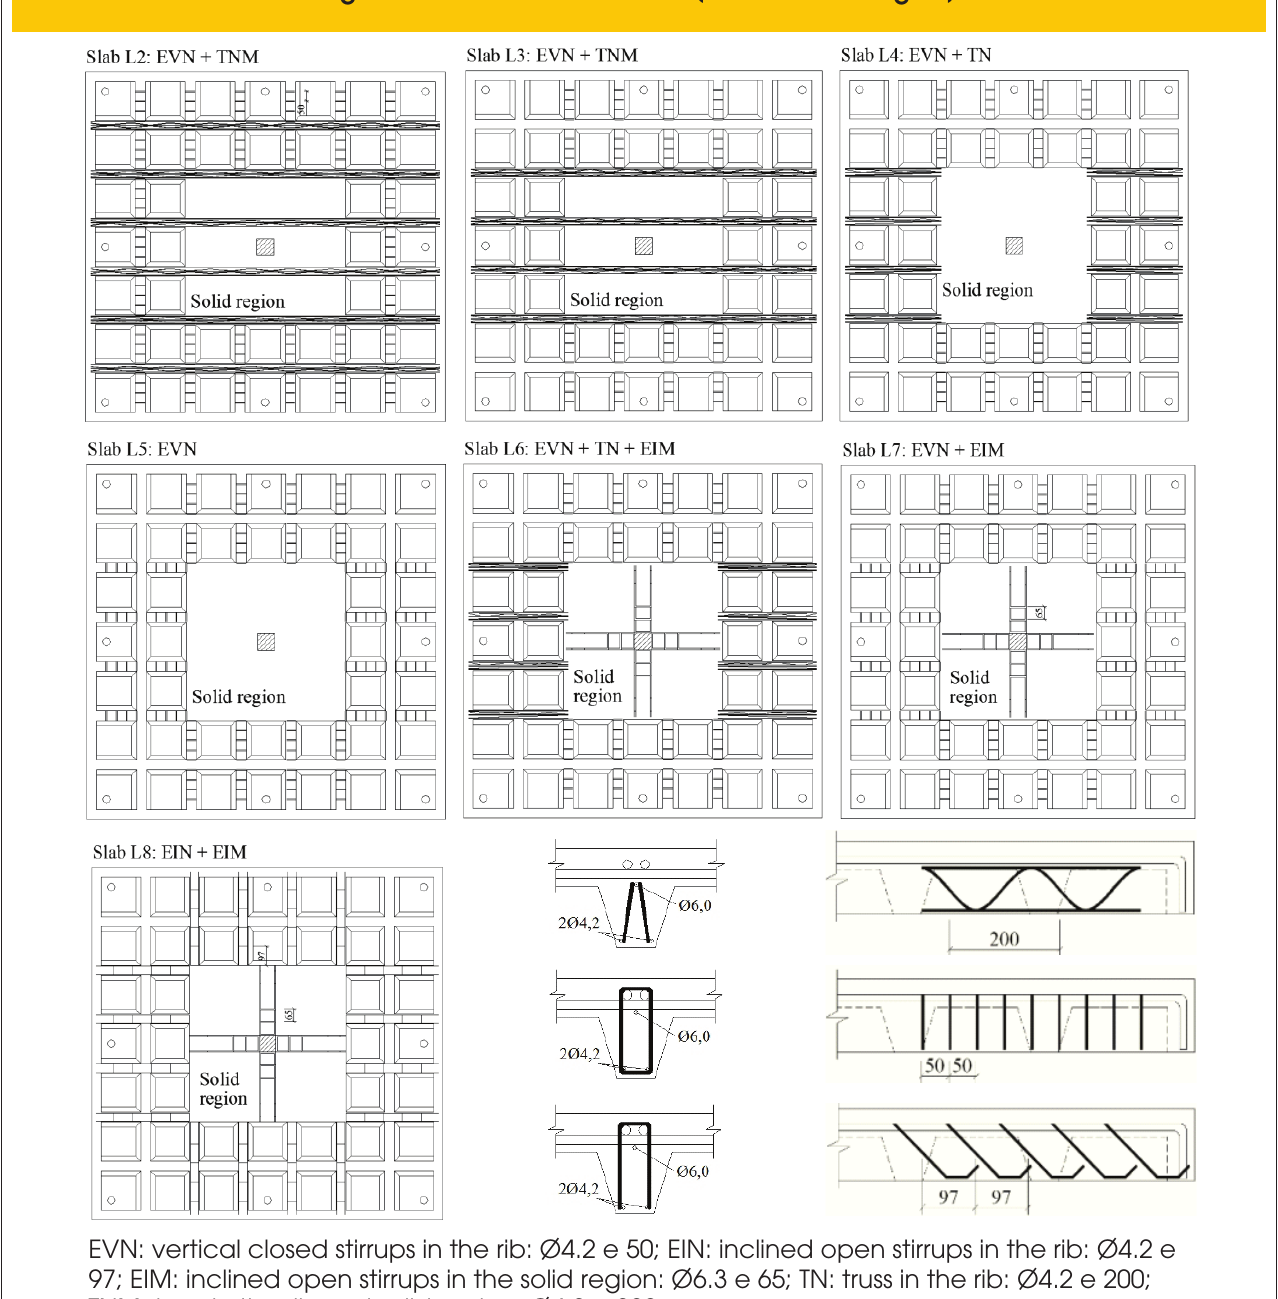
Figure 4 – Shear reinforcement (ribs and solid